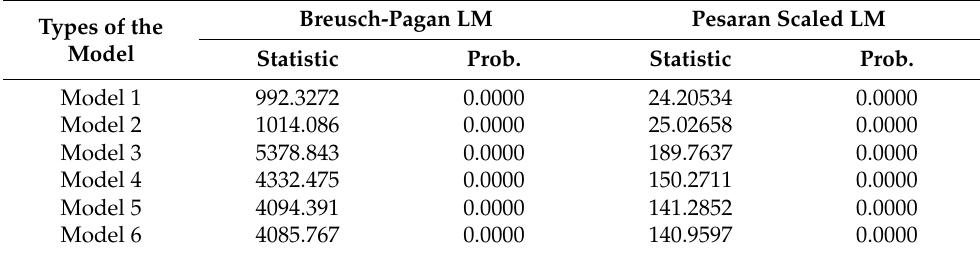
Table 4. The results of Breusch-Pagan LM and Pesaran scaled LM tests.